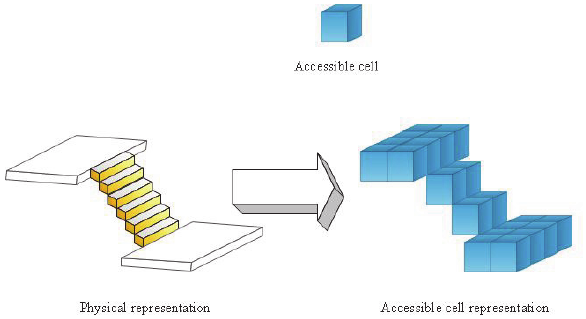
Figure 2. Diagram showing transformation from existing building structure data to pedestrian accessible cell